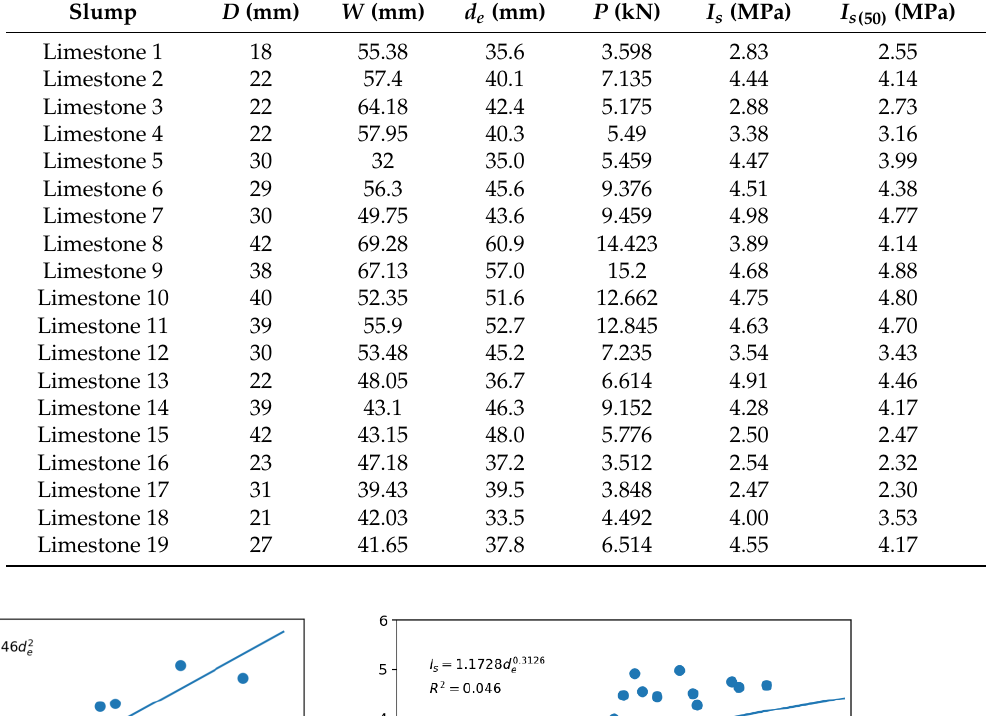
Table 5. Results of the point load test on limestone.